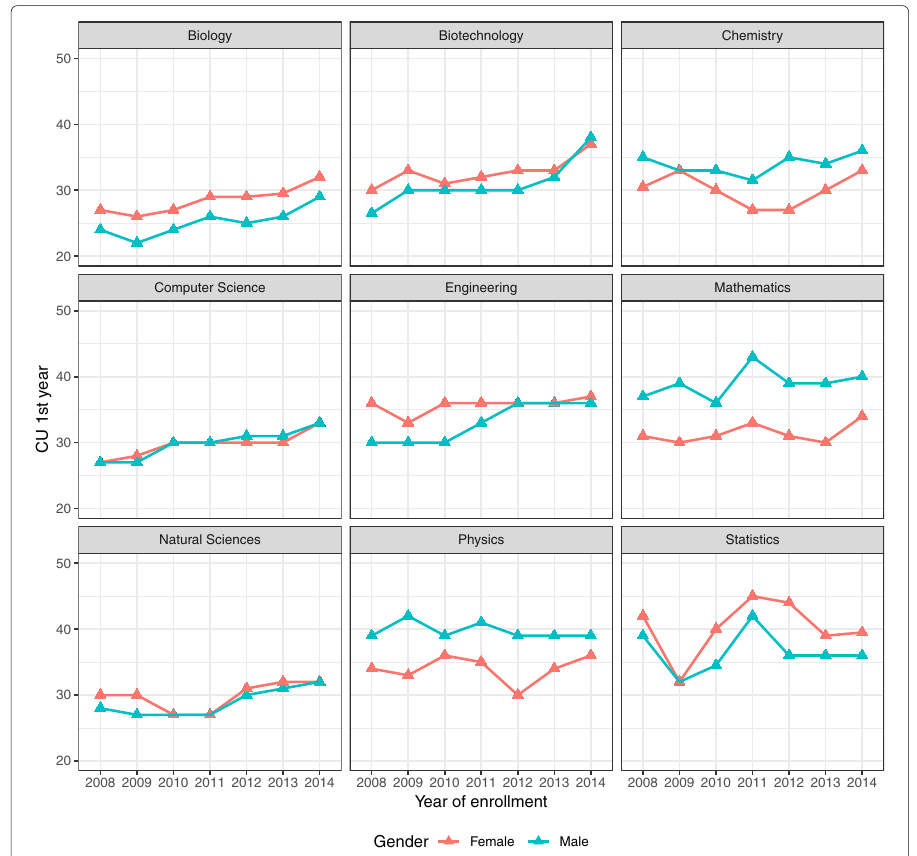
Fig. 1 Median values of the CUs earned at the end of the first year by male and female students enrolled at STEM degree courses. Cohort of freshmen enrolled in